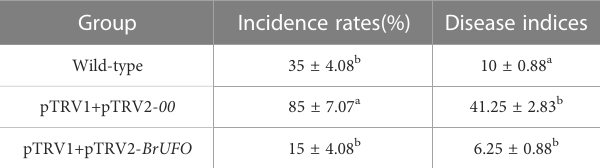
TABLE 2 Disease indices and incidence rates of BrUFO Silenced Chinese cabbage infected with P. brassicae . Group